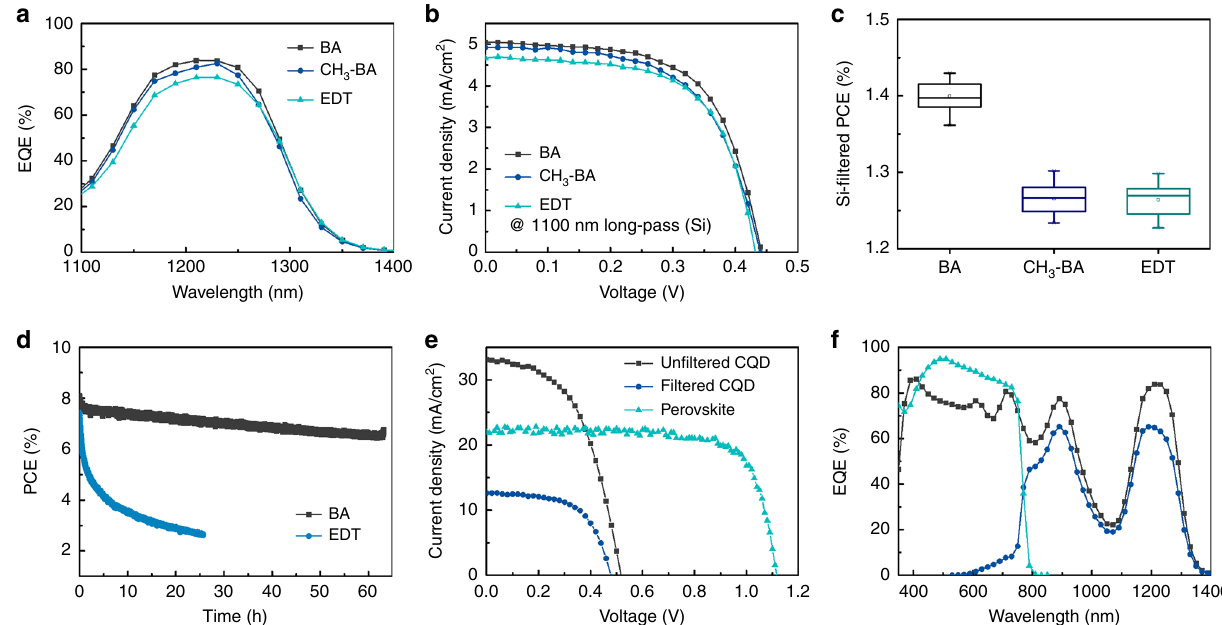
Fig. 4 CQD PV performance. a J – V characteristics of CQD PVs with different HTLs under AM 1.5 illumination with 1100-nm cutoff silicon fi lter. b EQE spectra of CQD PVs with different HTLs beyond 1100 nm. c Statistics of device performance with different HTLs using 1100-nm cutoff silicon fi lter. d MPP stability of unencapsulated CQD PVs with BA HTL and EDT HTL under continuous 1-sun illumination and nitrogen fl ow. e J – V characteristics and f EQE spectra of perovskite front cell and CQD back cell with BA HTL in the 4T tandem con fi